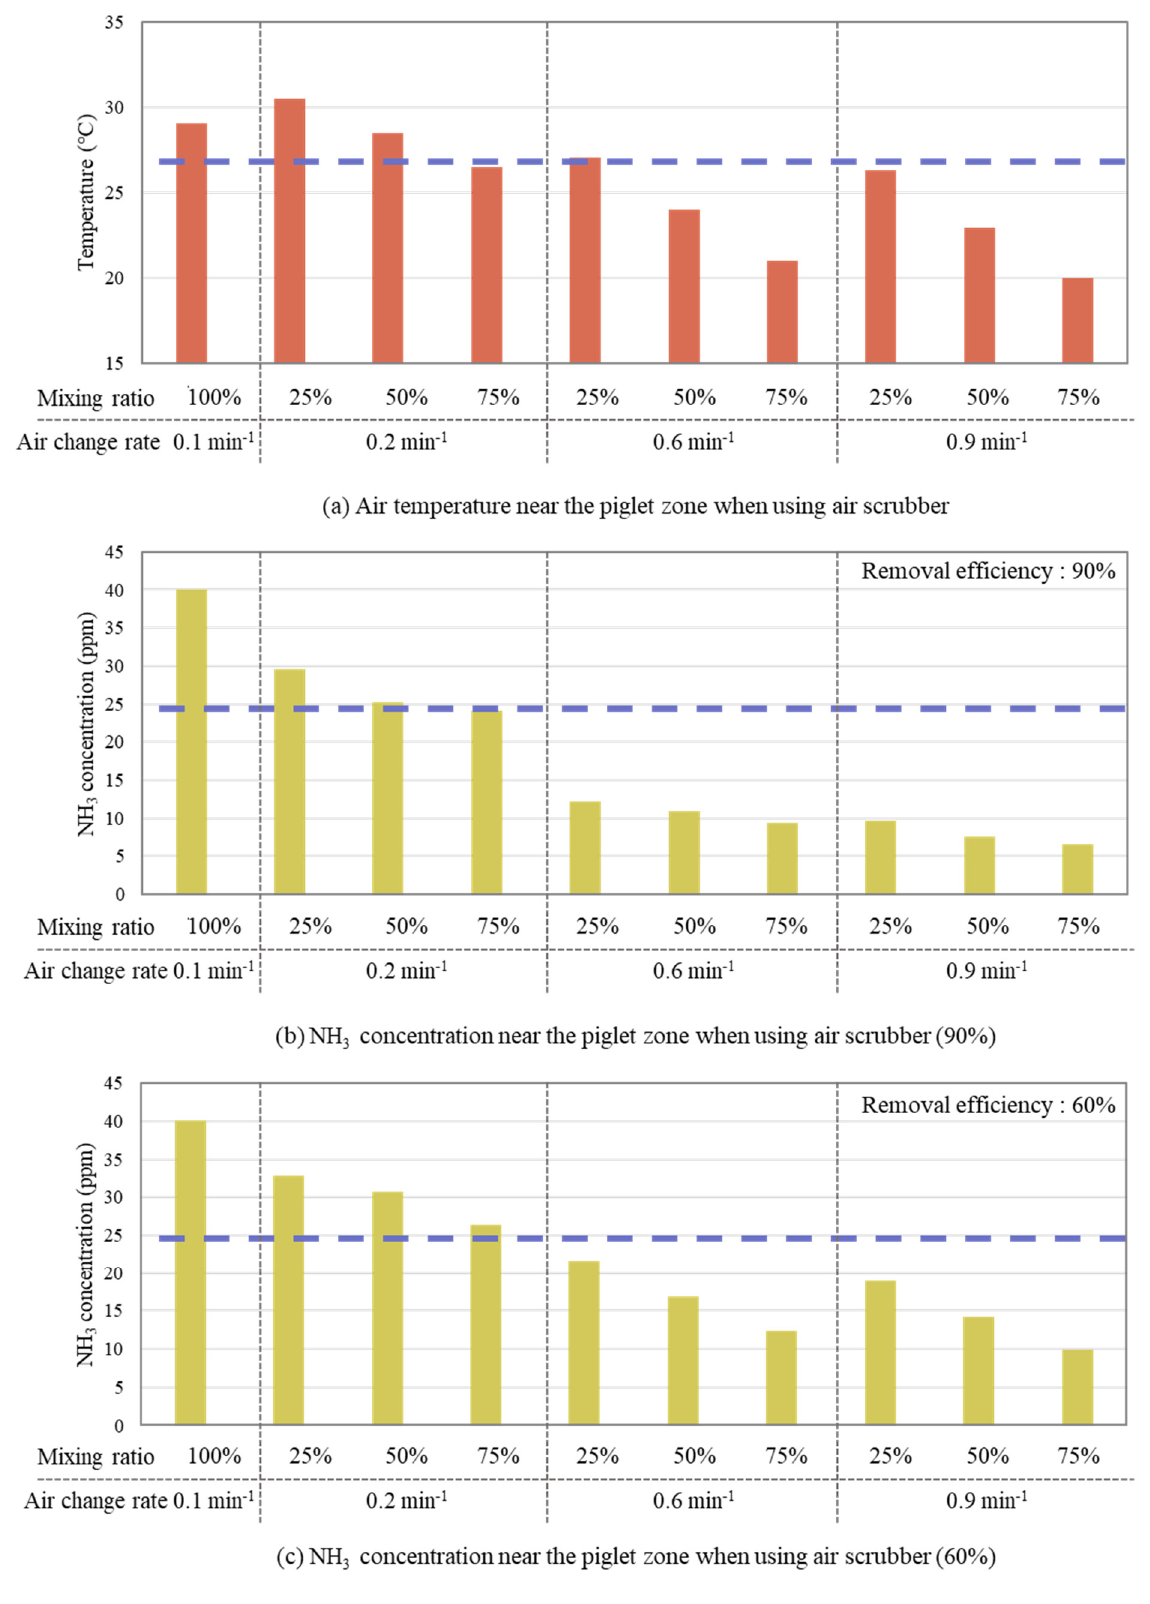
Figure 17. CFD computed results of temperature and ammonia concentration inside the experimental piglet house according to the ventilation rate and outdoor air mixing ratio using an air-recirculated ventilation system .